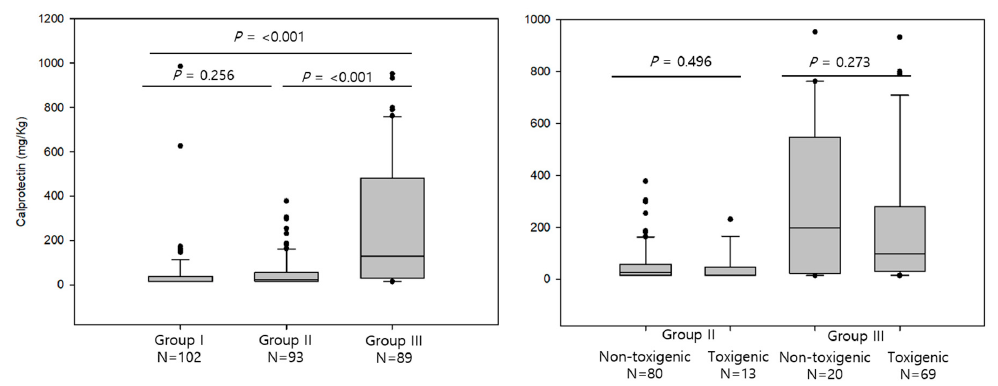
Figure 3. Fecal calprotectin levels in group I ( C. difficile non-colonized), group II ( C. difficile colonized), and group III (diarrhea with C. difficile ) are shown in left and the comparisons between non-toxigenic and toxigenic C. difficile within group II and group III are shown in right. Each p -value (I vs. III, I vs. II, II vs. III and non-toxigenic vs. toxigenic C. difficile ) was presented. The box plot shows the median and interquartile values . The whiskers indicate 1.5 times the interquartile range above and below the 75th and 25th percentiles. The circles indicate the outliers.